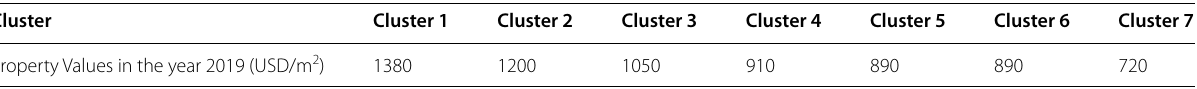
Table 4 Property prices within the clusters of the study area for the year 2019